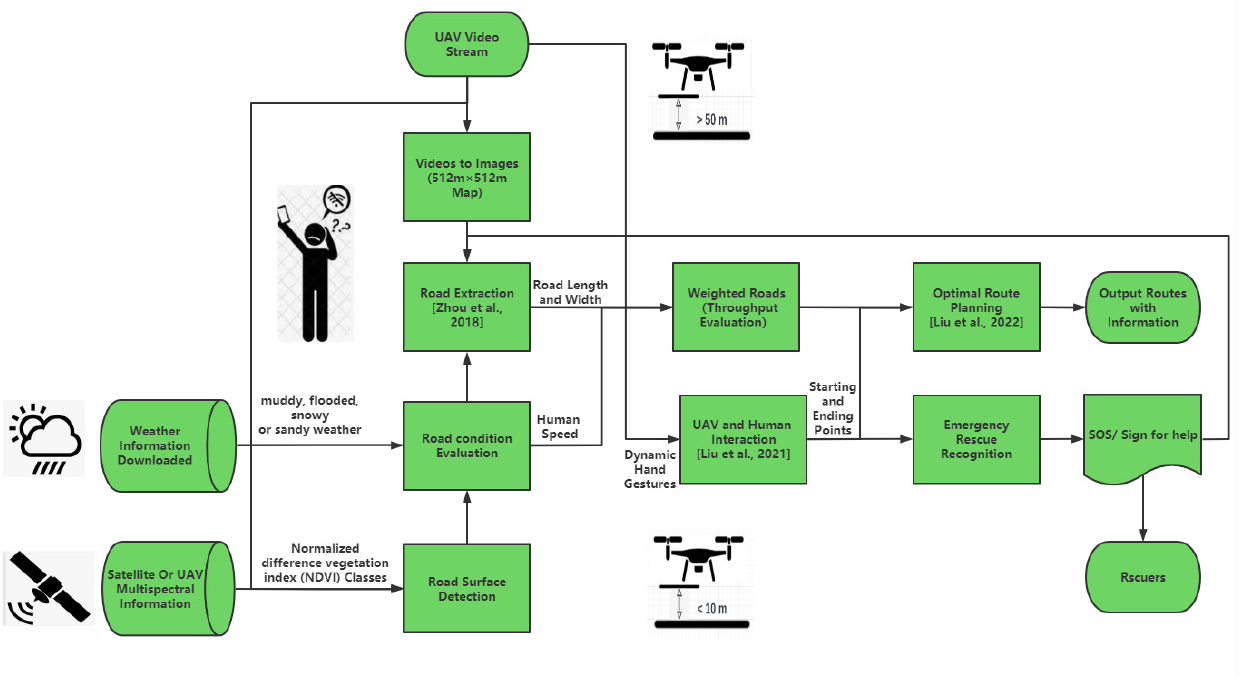
Figure 4. Flowchart of the proposed whole system [30,47,48].